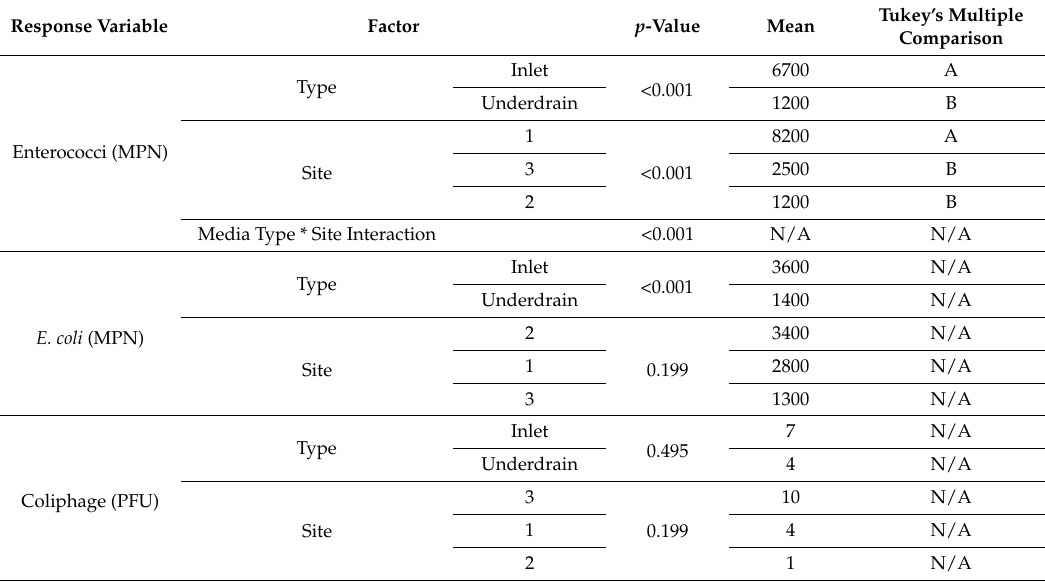
Table 7. Two-way ANOVA (analysis of variance) results for three bioretention cells in Grove, Oklahoma using three microbes, enterococci, E. coli , and coliphage as response variables and type (inlet, underdrain) and site (ECP: Elm Creek Plaza, GLA: Grand Lake Association, GHS: Grove High School) as factors.